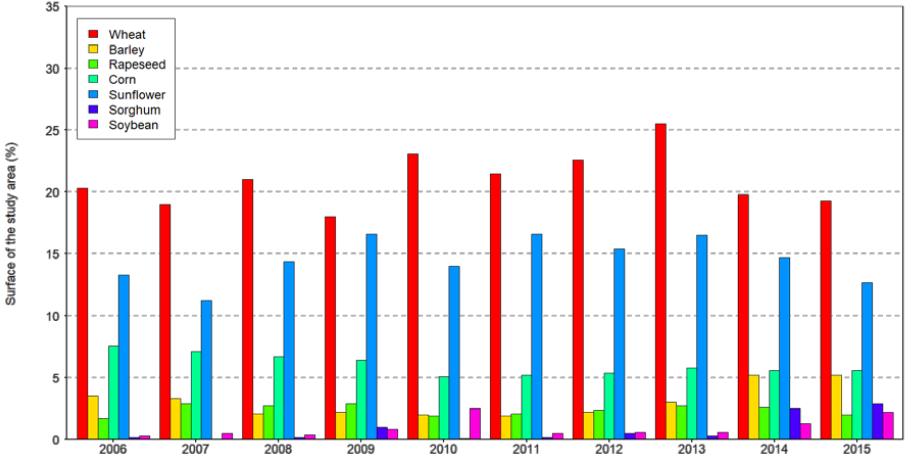
Figure 4. Temporal evolution of the agricultural land use considering 7 classes: wheat, barley, corn, sunflower, sorghum and soybean (expressed in % of the study